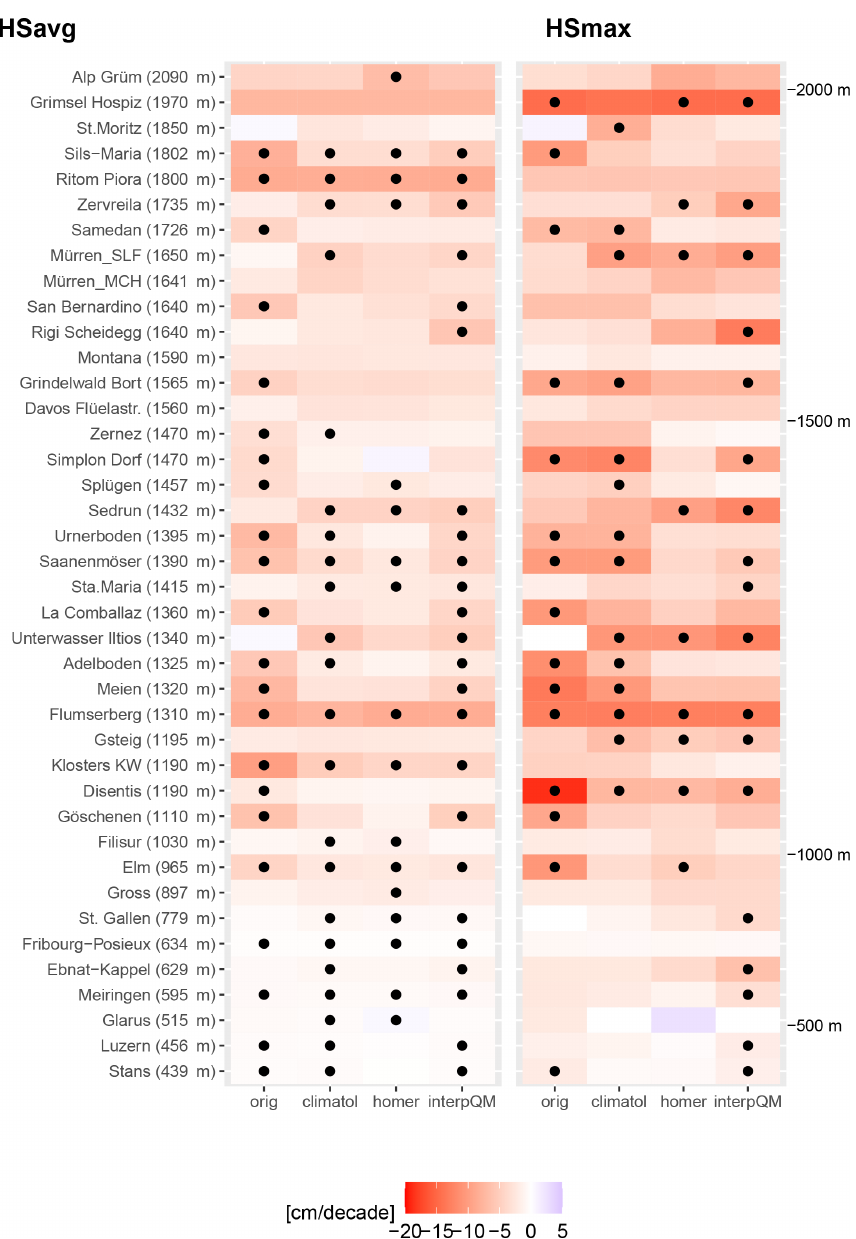
Figure 4. Comparison of trends calculated with original and homogenised data (Climatol, HOMER, and interpQM) for the period 1961– 2021 for HSavg (left-hand side) and HSmax (right-hand side). Stations are ordered according to elevation. Black dots indicate statistical significance with p values below